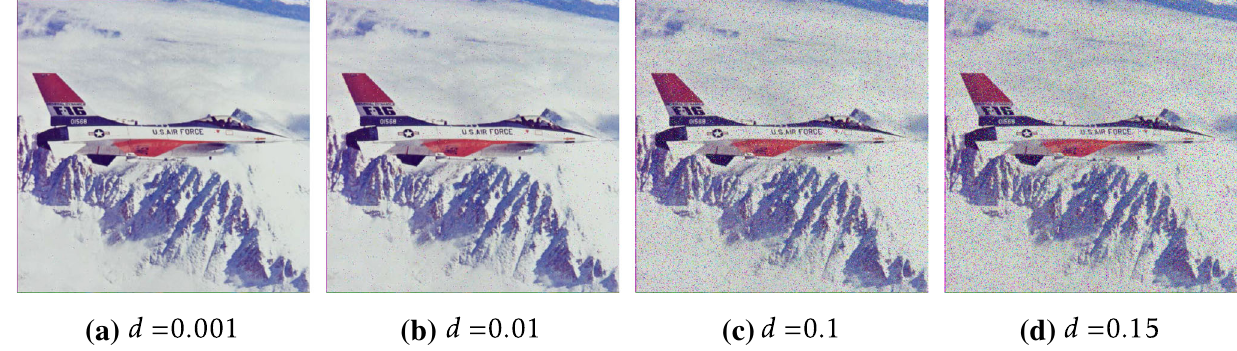
Fig. 10 Noise attack, in which the defective encrypted images through applying Salt & Pepper noise with varying densities are